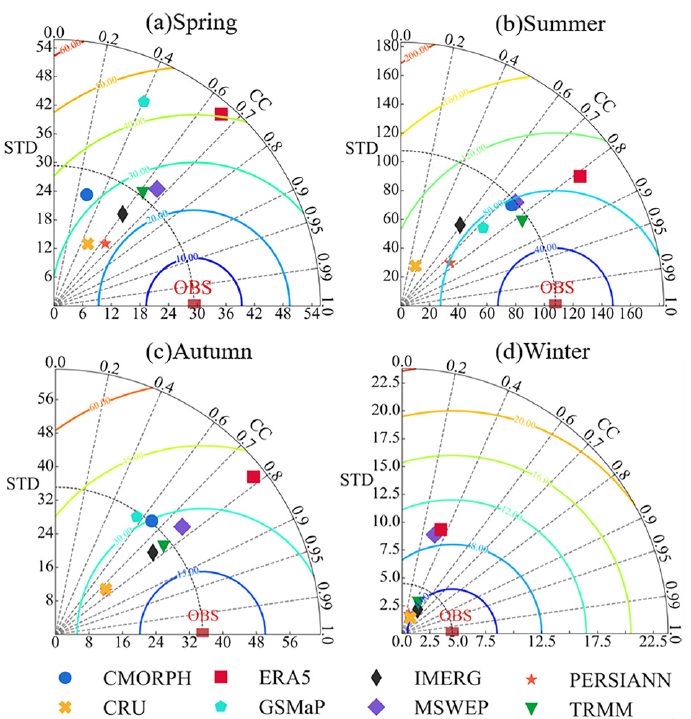
Figure 7. Taylor diagrams of seasonal precipitation estimates from each product in comparison with observations at stations over the HRB during 2016–2019. observations at stations over the HRB during